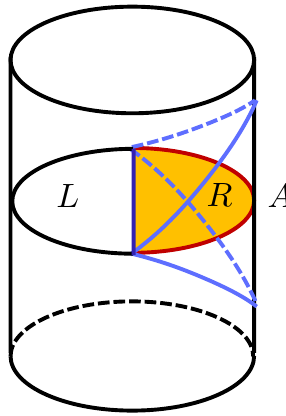
Figure 1 . AdS-Rindler patch in the global AdS